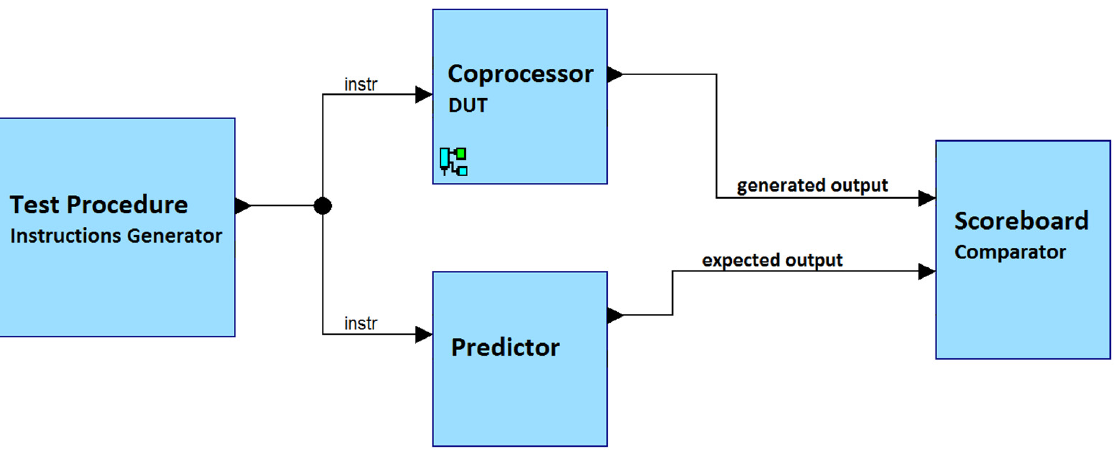
Figure 8. Testbench architecture.